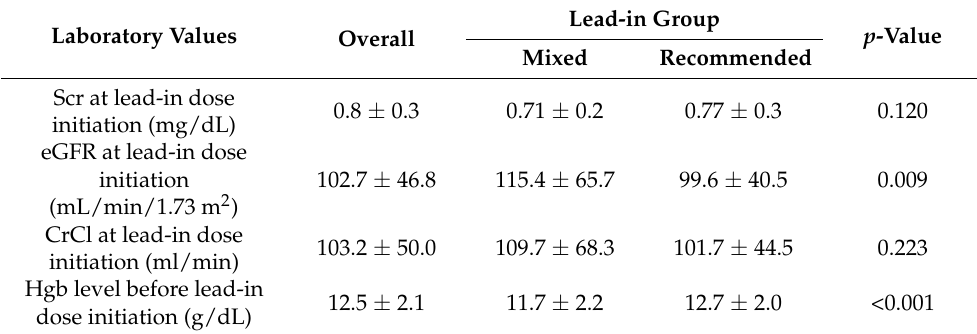
Table 2. Laboratory values at the lead-in dose initiation.